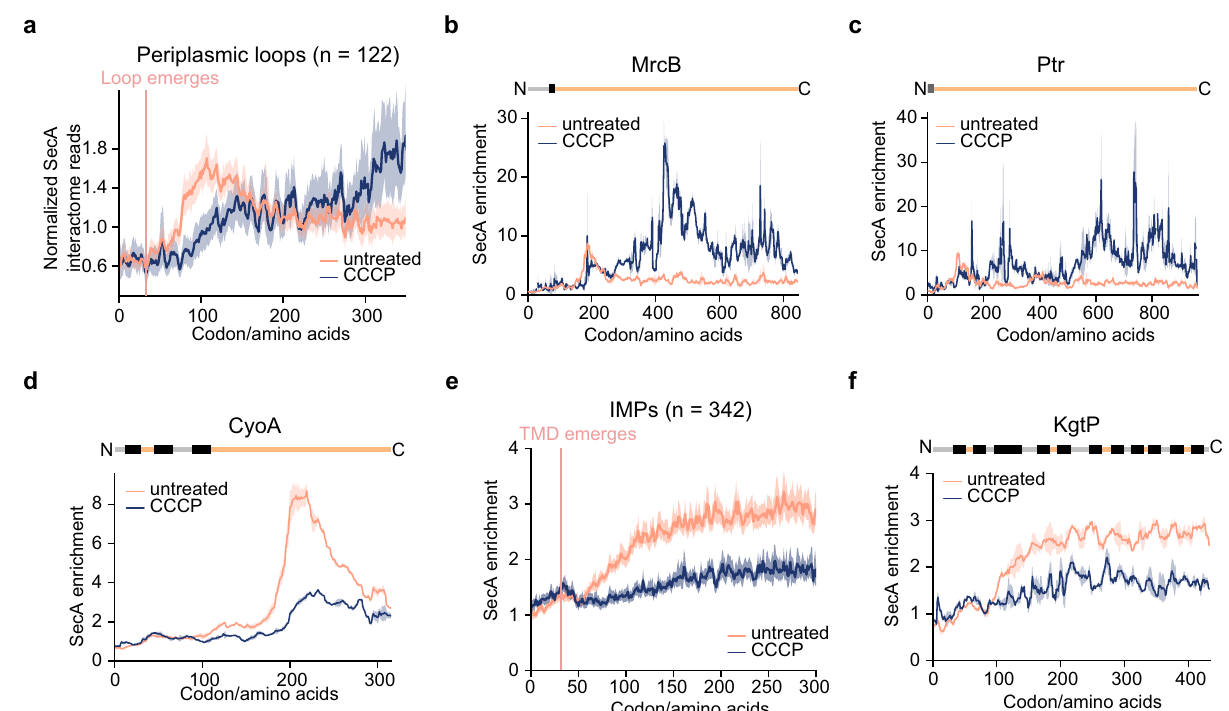
Fig. 6 PMF regulates cotranslational SecA interactions. a Metagene SecA interactome pro fi le of periplasmic loops larger than 100 amino acids aligned to their N-terminus. Solid lines show the mean values, and shaded areas show the 95% CI. b , c Representative SecA interaction pro fi le of an IMP with a large periplasmic loop ( b ) and a secretory protein ( c ) that showed persistent SecA association upon CCCP treatment. Protein topology is shown above and colored as in Figs. 2b and 4c. d Representative SecA interaction pro fi le of an IMP with a large periplasmic loop that showed signi fi cantly reduced SecA association upon CCCP treatment. Protein topology is shown above and colored as in Fig. 2b. e Metagene SecA enrichment of IMPs with no periplasmic loops longer than 45 amino acids aligned to the N-terminus of their fi rst TMD. The median SecA enrichment values in CCCP-treated and untreated cells are compared. Shaded areas show the 95% CI. f Representative SecA interaction pro fi le of an IMP without a large periplasmic loop in untreated and CCCP- treated cells. Protein topology is shown above and colored as in Fig. 2b. In b , c , d , f , solid lines show the mean values, and shaded areas show the range of data from two independent biological